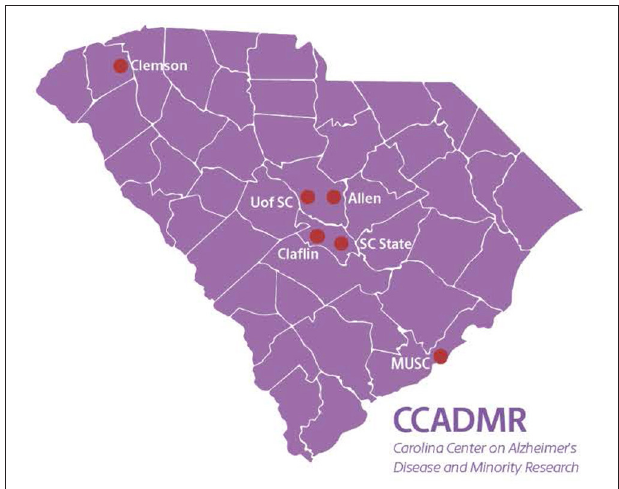
FIGURE 1 | Academic affiliations of the Carolina Center on Alzheimer’s Disease and Minority Research.